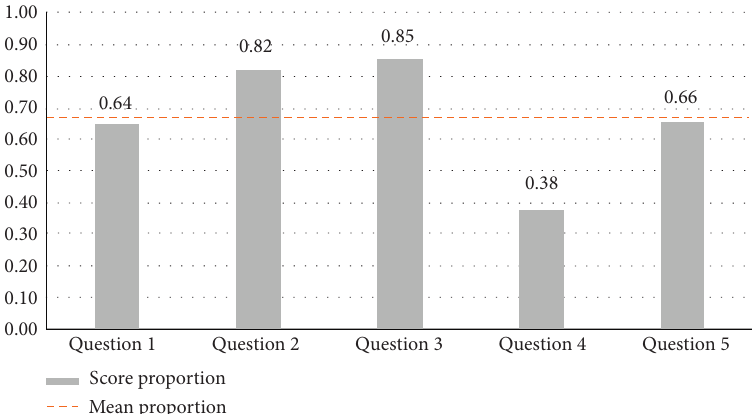
Figure 6: Percentage of the score for the expert’s